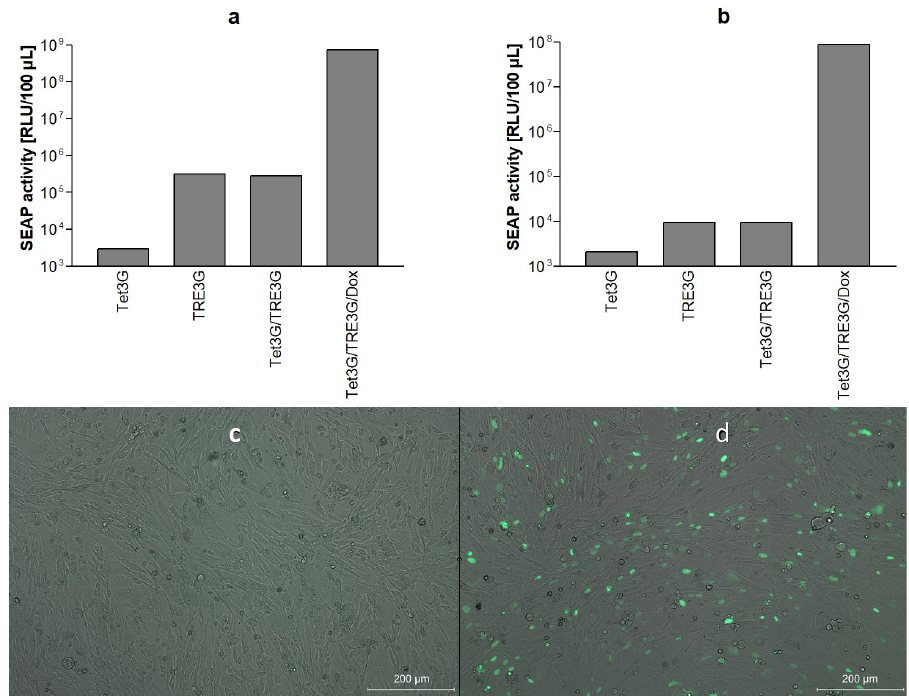
Figure 1. Function of bicistronic SEAP/EYFPNuc reporter gene cassette. Cells cultivated in 24-well plates were transiently transfected with transactivator Tet3G plasmid pCMV-Tet3G (Tet3G), reporter gene plasmid pTRE3G-SEAP-EYFPNuc (TRE3G), both (Tet3G/TRE3G) or both treated with doxycycline (Tet3G/TRE3G/Dox) as indicated, using 100 ng plasmid, respectively, and SEAP secreted into culture supernatants was quantified 24 h later, panel ( a ): BHK-21 cells, panel ( b ): Vero E6 cells. Induction of EYFPNuc expression in BHK-21 cells co-transfected with pCMV-Tet3G and pTRE3G- SEAP-EYFPNuc in the absence ( c ) or presence ( d ) of 10 µ M doxycycline was analyzed by fluorescence microscopy (transmission light microscopy of intact cells overlayed by